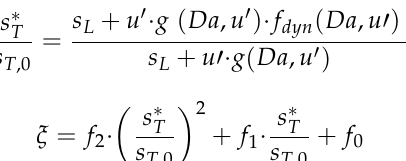
, green). Results for Da L , CFD